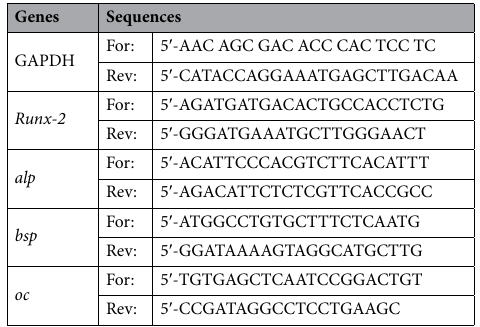
Table 1. Sequences of primers used for real-time PCR